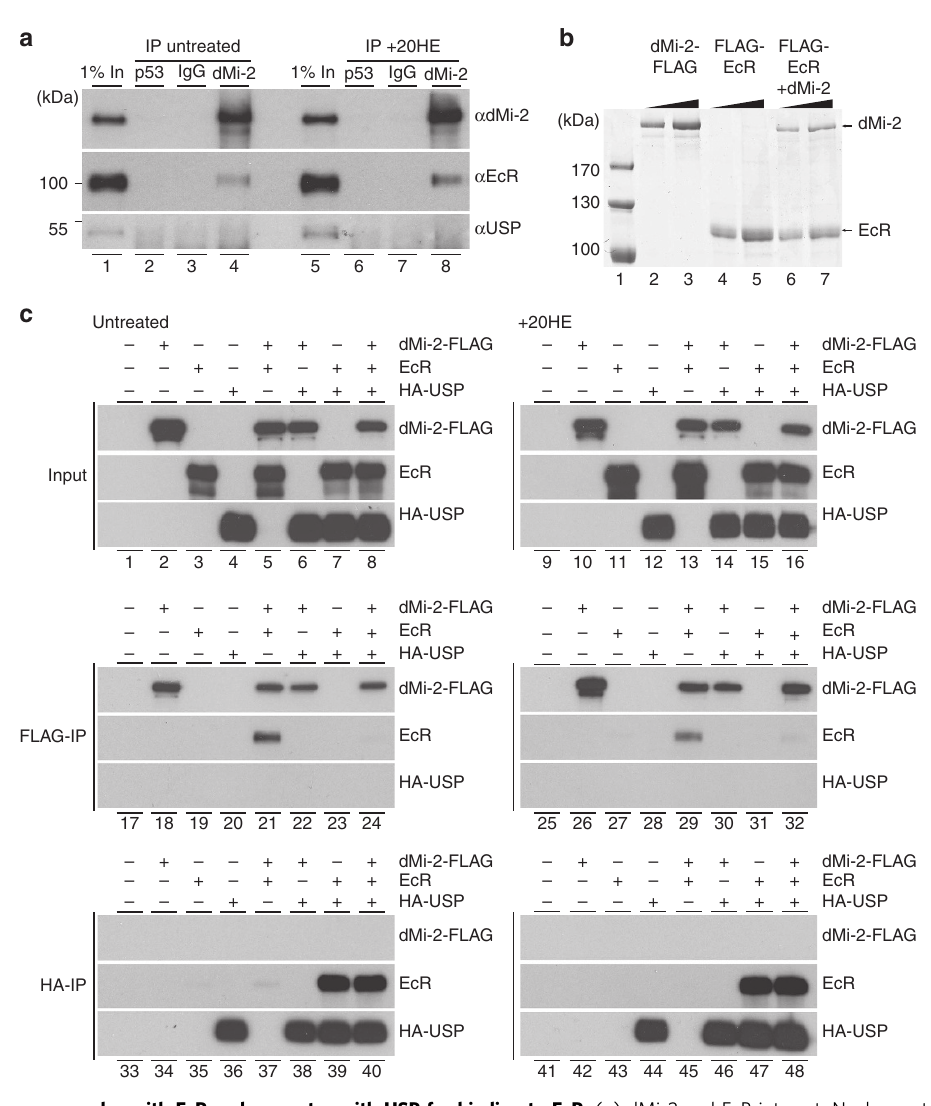
dMi-2 immunoprecipitate (middle left panel, lane 24). These results indicate that USP and dMi-2 compete for binding to EcR.